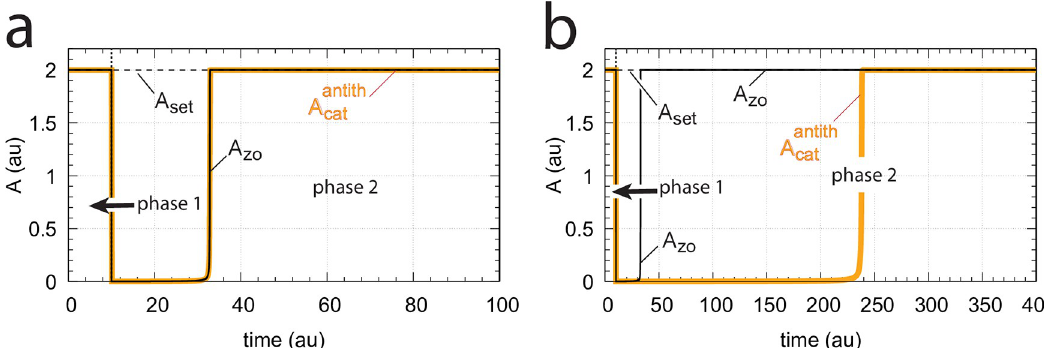
Fig 8. Avoiding enzyme overload. Same system as in Fig 7 with perturbation 3 applied, i.e., during phase 1 (0–10 time units) k 2 =10.0, while during phase 2 k 2 = 2 × 10 4 . All other rate constants are as in Fig 7, except that in panel (a) the total amount of enzyme Ez has been increased by one order of magnitude to Ez 0 =10 − 5 , while in panel (b) Ez 0 =10 − 6 , but k 5 and k 6 have been decreased in phase 2 by one order of magnitude to 1.0 and 2.0, respectively. Initial concentrations: (a) A 0 =2.0, E 1,0 =454.4, E 2,0 =0.0204,